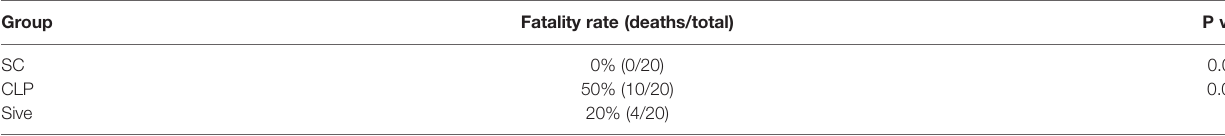
TABLE 1 | Twenty-four-hour mortality of animals in each experimental group. Group Fatality rate